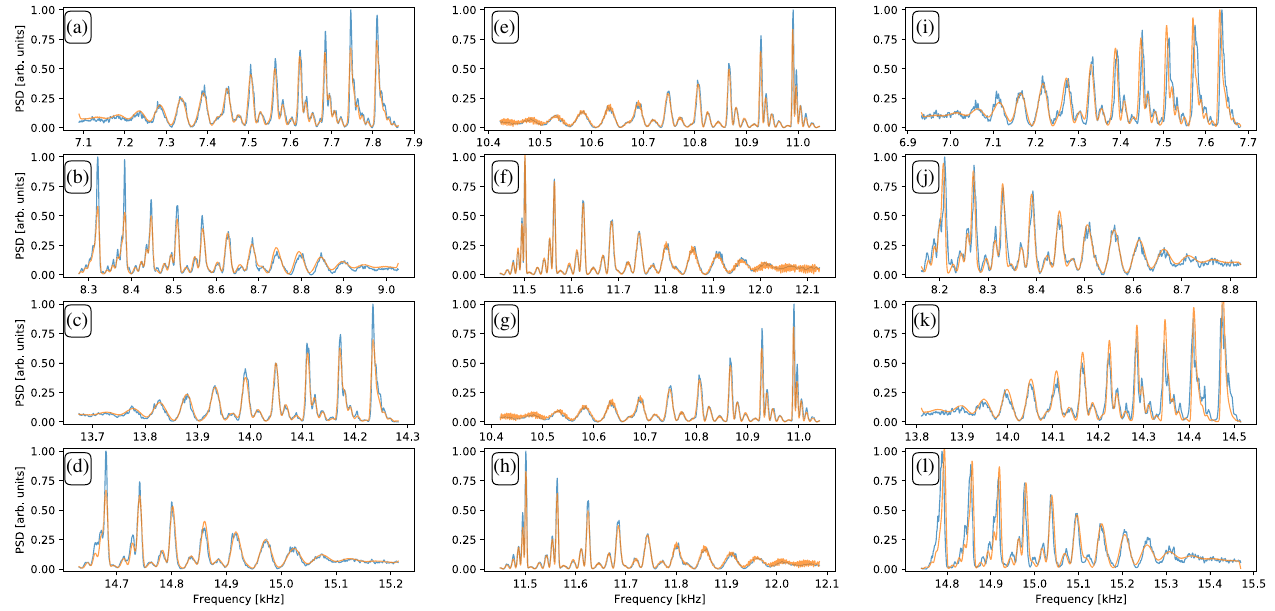
FIG. 4. Measured (blue lines) transverse and longitudinal Schottky spectrum for LHC fill 7443, compared with the best fitted spectrum (orange lines) obtained from the second scenario strategy. A – L region labels correspond to frequency ranges equivalently located as shown in Fig. 3 for fill